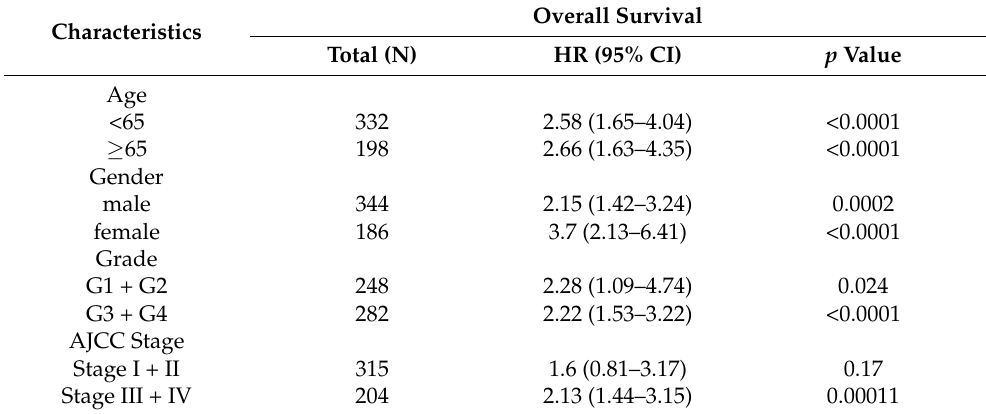
Table 2. Correlation of FDX1 mRNA expression and prognosis in different subgroup ccRCC patients.